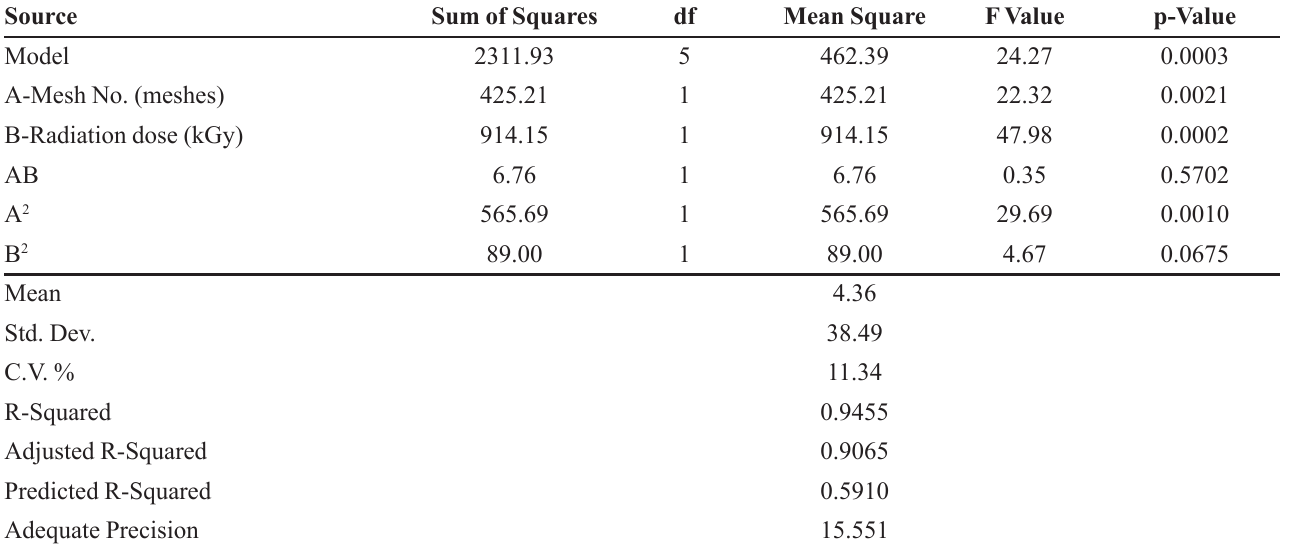
TABLE IID - Analysis of variance (ANOVA) from the final reduced models for linoleic acid reduction capacity of irradiated maize